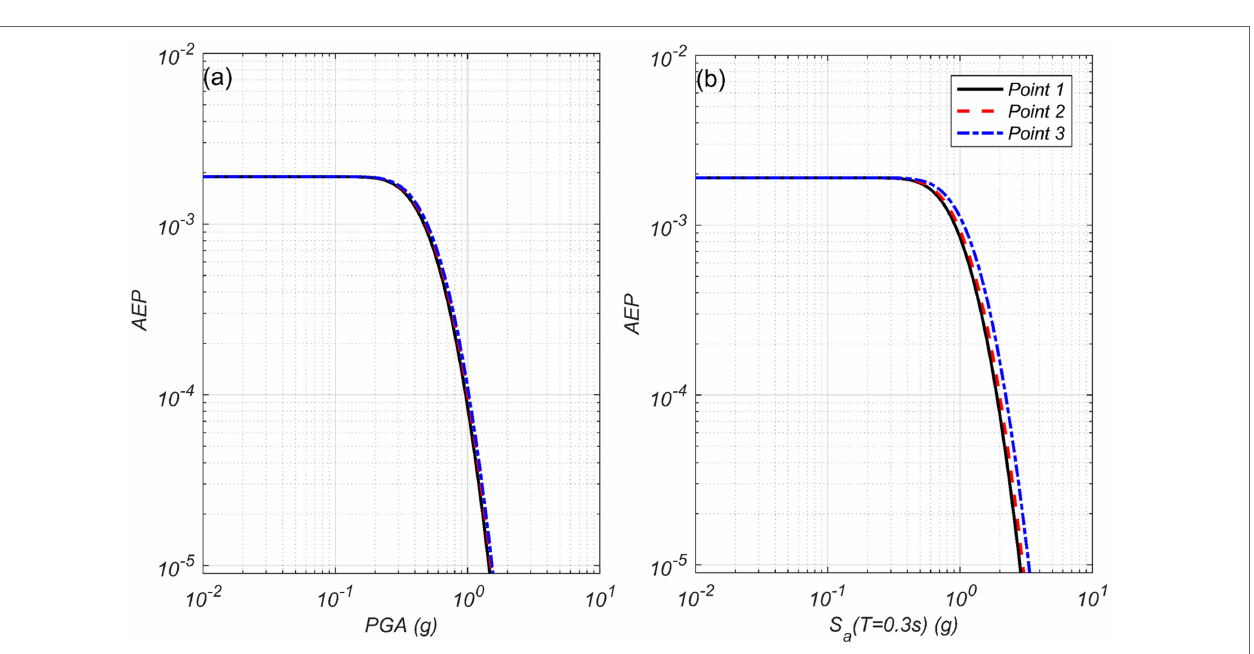
scenariofromtheprecomputedclosestdistances. Figure7B shows the PMF of R rup computed for observation point 1 in Figure 5A